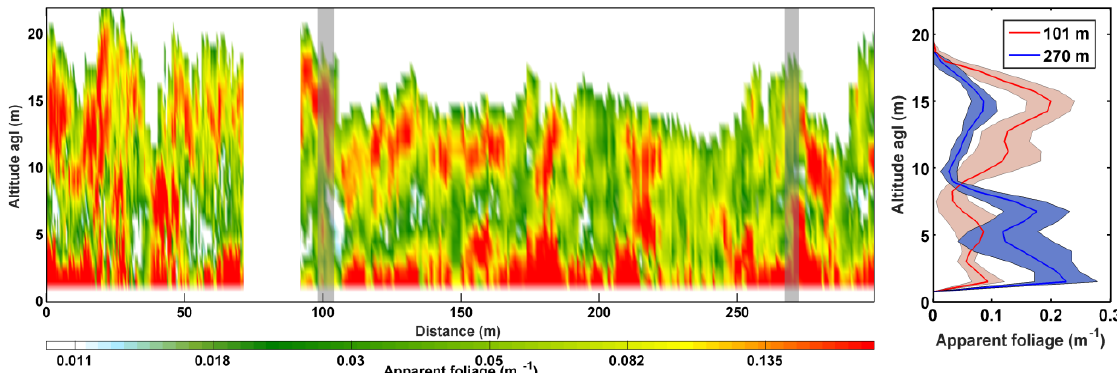
Figure 9. Evolution of the forest vertical profile of the LiDAR-derived apparent foliage ( F app ) along a transect of the Tamarind site (TM, left panel). Two specific vertical profiles are given in the right panel, and their locations are highlighted in transparent gray in the left panel. The gap between the distances of 70 to 90 m corresponds to LiDAR shots with big pointing angles (the angle between the actual LiDAR line of sight and the nadir direction is larger than 20 ˝ ), which were not considered in our